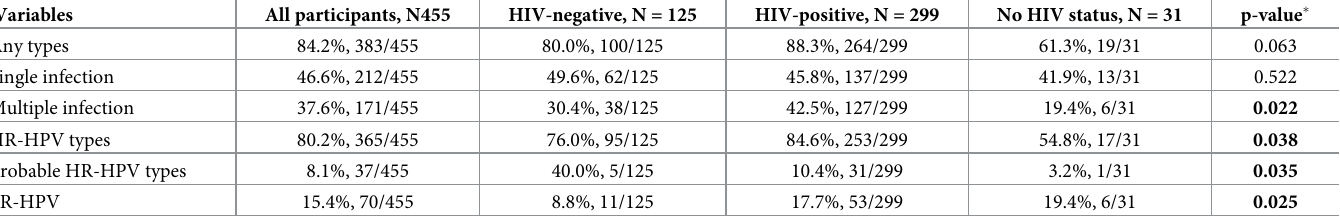
Table 2. Prevalence of HPV infection according to HIV status among women referred to Nelson Mandela Academic Hospital Gynaecology department, Eastern Cape Province. Variables